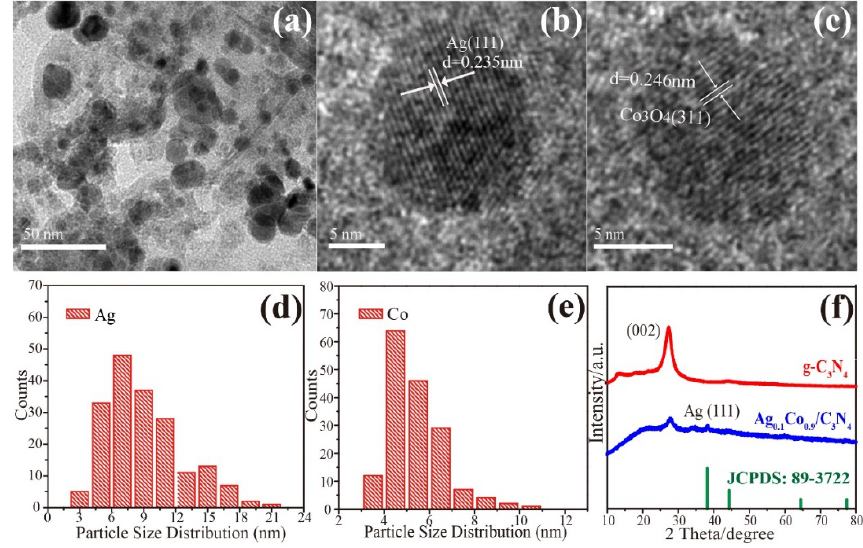
Figure 1. ( a ) TEM images of Ag 0.1 Co 0.9 /g-C 3 N 4 . HRTEM images of ( b ) Ag nanoparticles and ( c ) Co 3 O 4 nanoparticles. ( d ) Particle size distribution of Ag nanoparticles. ( e ) Particle size distribution of Co nanoparticles. ( f ) XRD patterns of g-C 3 N 4 and Ag 0.1 Co 0.9 /g-C 3 N 4 .